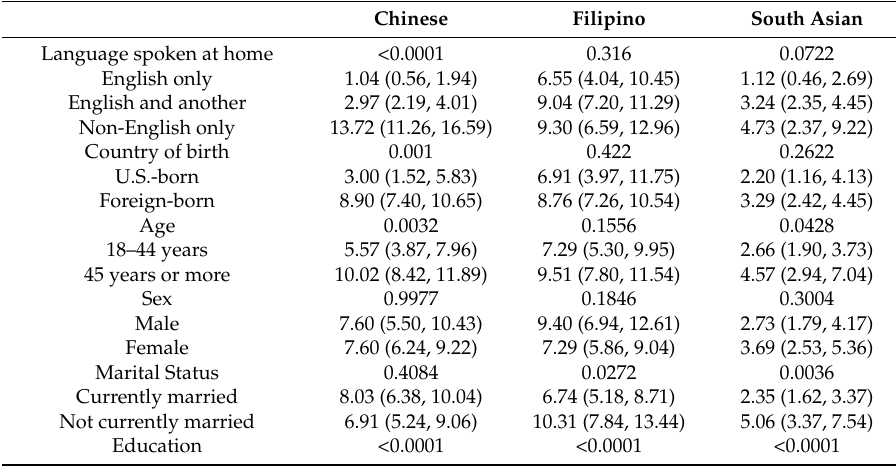
Table 2. Association between prevalence of food insecurity and study population characteristics, by Asian American subgroups, results of chi-square